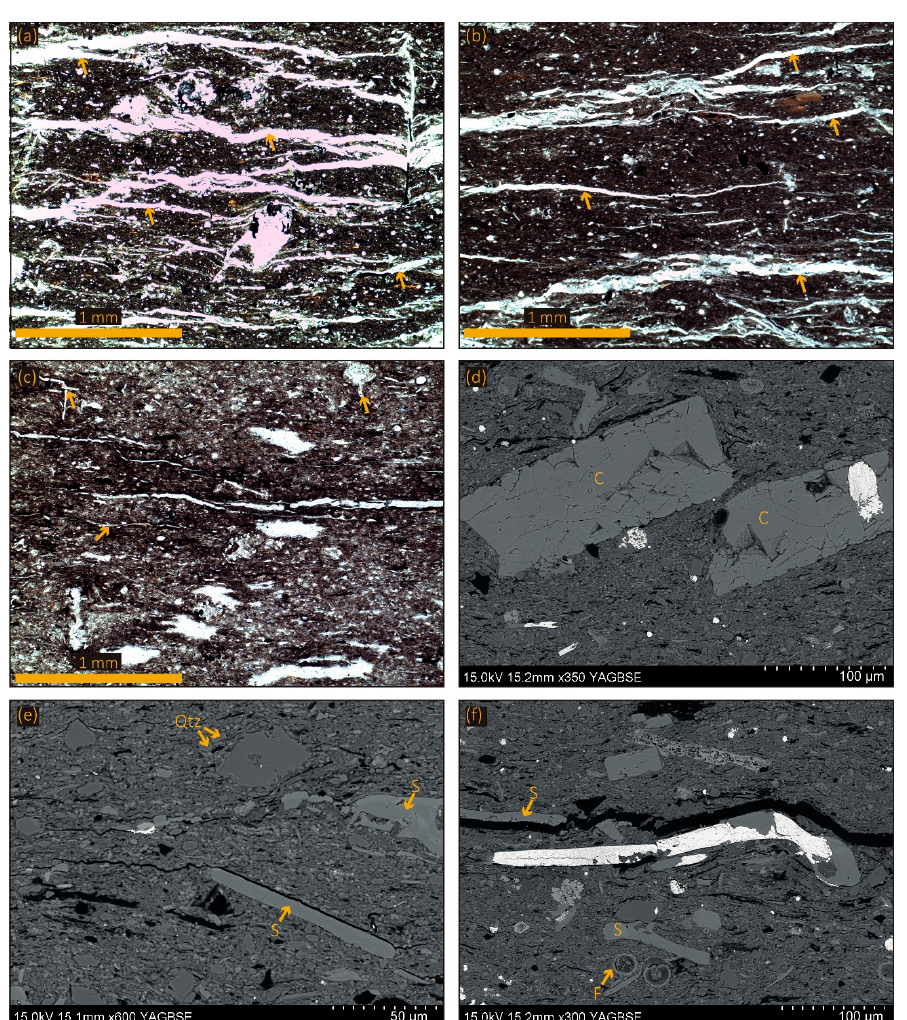
Figure 7. Facies 5: Biogenic detritus dominated, fine to medium mudstone. Sample EB 71.00 m. ( a – c ) Optical photomicrographs showing a network of discontinuous calcareous structures (pointed to by the yellow arrows) through an argillaceous matrix. ( d ) Backscattered electron photomicrograph showing calcareous rhombs that have been partially replaced by pyrite. ( e ) Backscattered electron photomicrograph showing calcareous shell fragments (S) and abundant quartz grains (Qtz) in an argillaceous matrix. ( f ) Backscattered electron photomicrograph showing a calcitic shell that has been partially replaced by pyrite. Note the presence of well-preserved foraminifera tests (F).